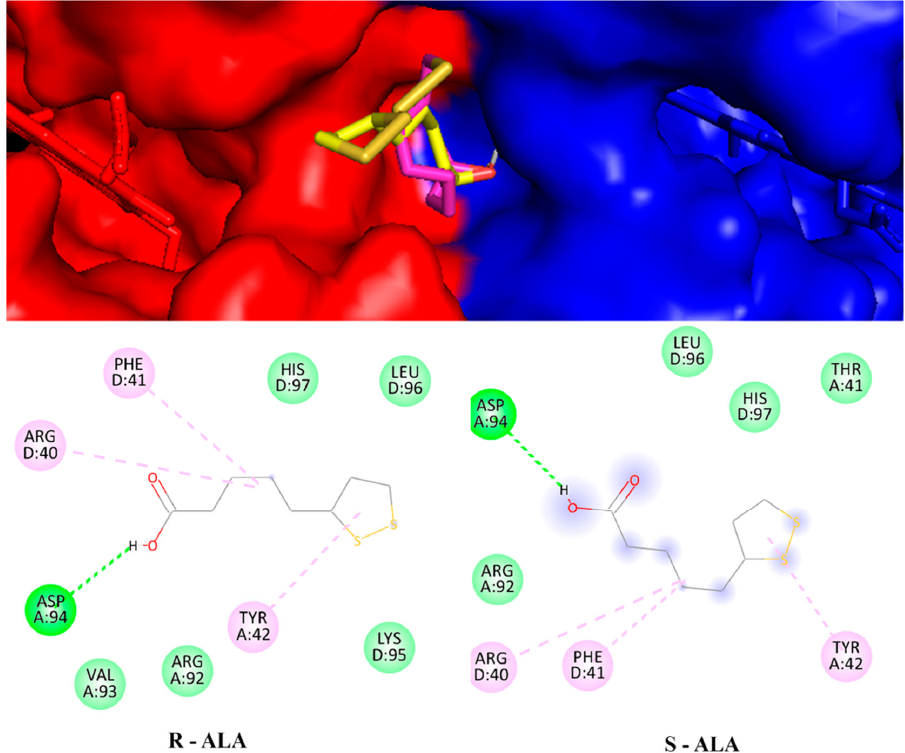
Figure 9. Hemoglobin structure is anchored with the ligands R-ALA and S-ALA between the A (blue) and D (yellow) chains and their respective interaction